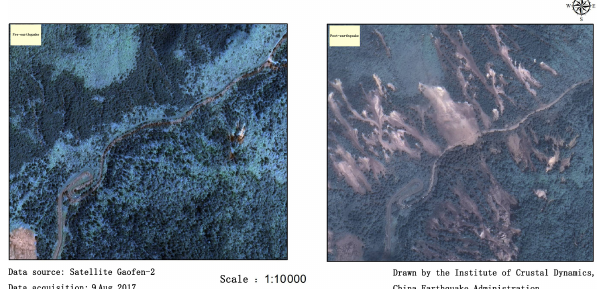
Figure 4. Comparison of remote sensing images surveying the road damage before and after the earthquake along the No. 301 provin- cial highway, Jiuzhaigou County, Sichuan